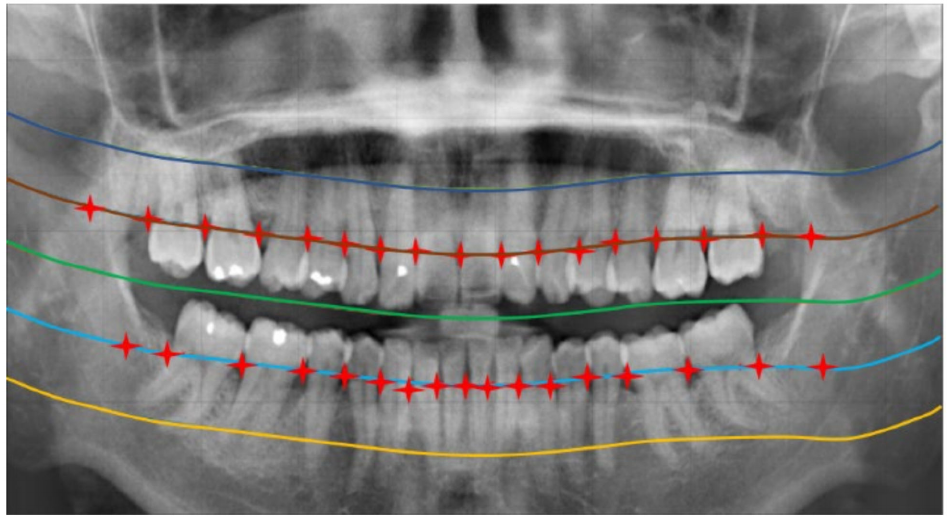
Figure 18. Correction of the supplement point’s position.